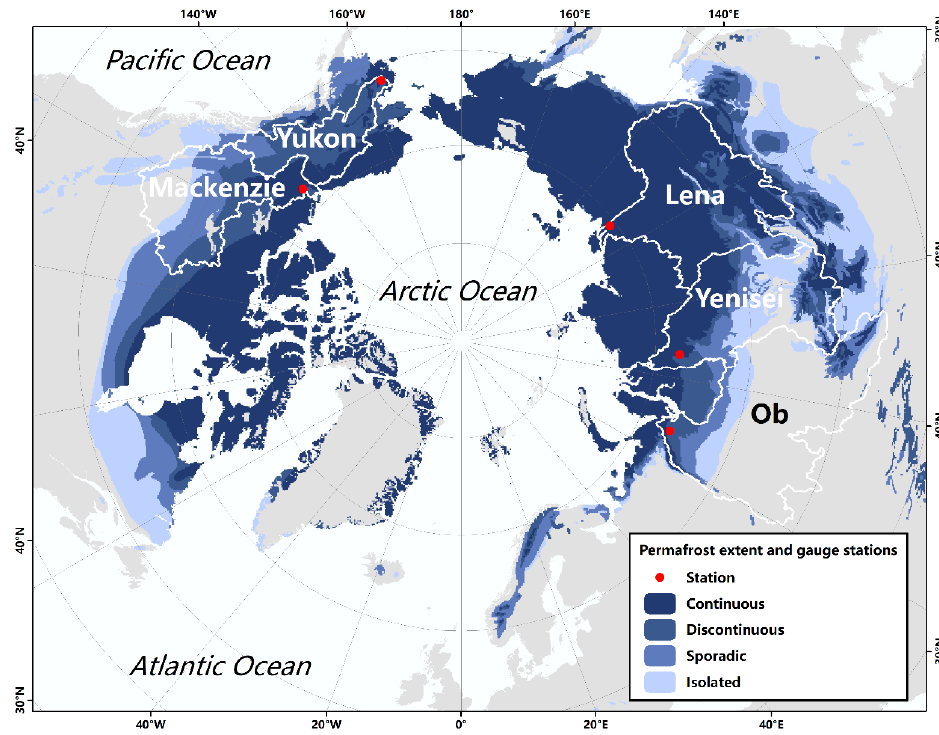
Figure 1. Locations of the five large pan-Arctic river basins: Lena, Yenisei, Ob, Mackenzie, and Yukon (https://worldmap.harvard.edu/data/geonode:wribasin_1eu, accessed on 1 March 2021); distribution of permafrost (https://nsidc.org/data/GGD318/versions/2, accessed on 13 April 2021) [20]; and locations of gauge stations.